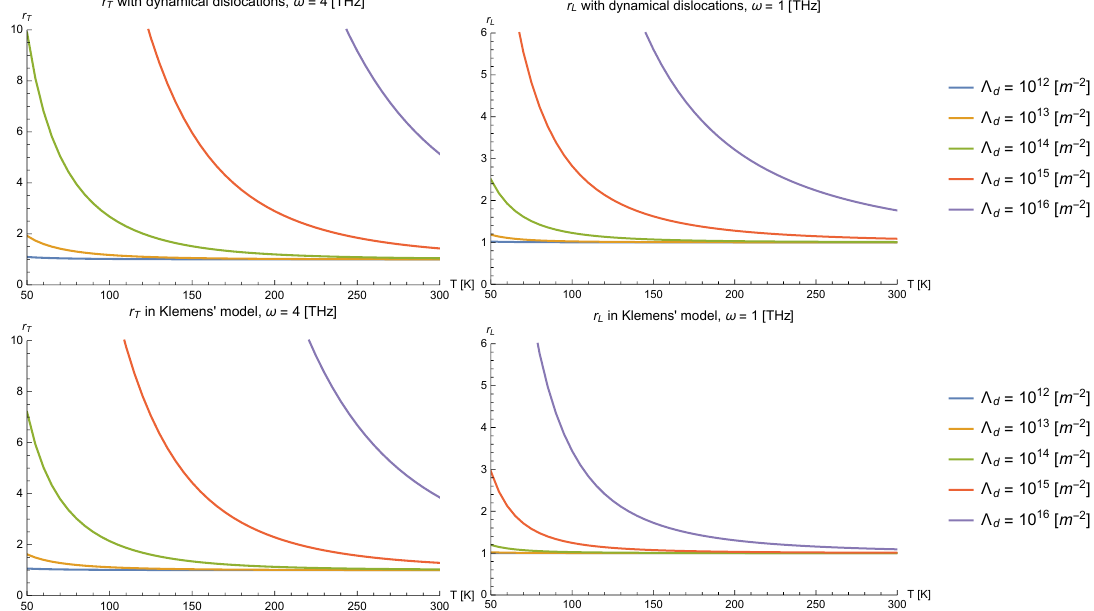
Figure 9. Differential anisotropy ratio r ι as a function of temperature T for different dislocation densities Λ d . Upper panels: Present work, based on a dynamical response of dislocations to phonons. Lower panels: Klemens model, based on a static response of dislocations to phonons. Left panels: Transverse polarization at ω = 4 THz. Right panels: Longitudinal polarization at ω = 1 THz. The plots were calculated for γ = 2, g = 3, G = 2, b = 3.5 × 10 − 10 m, and the intrinsic phonon lifetime parametrizations of Ge [45]. There is no significant difference between the behavior of the static and dynamic dislocations other than the overall strength of the